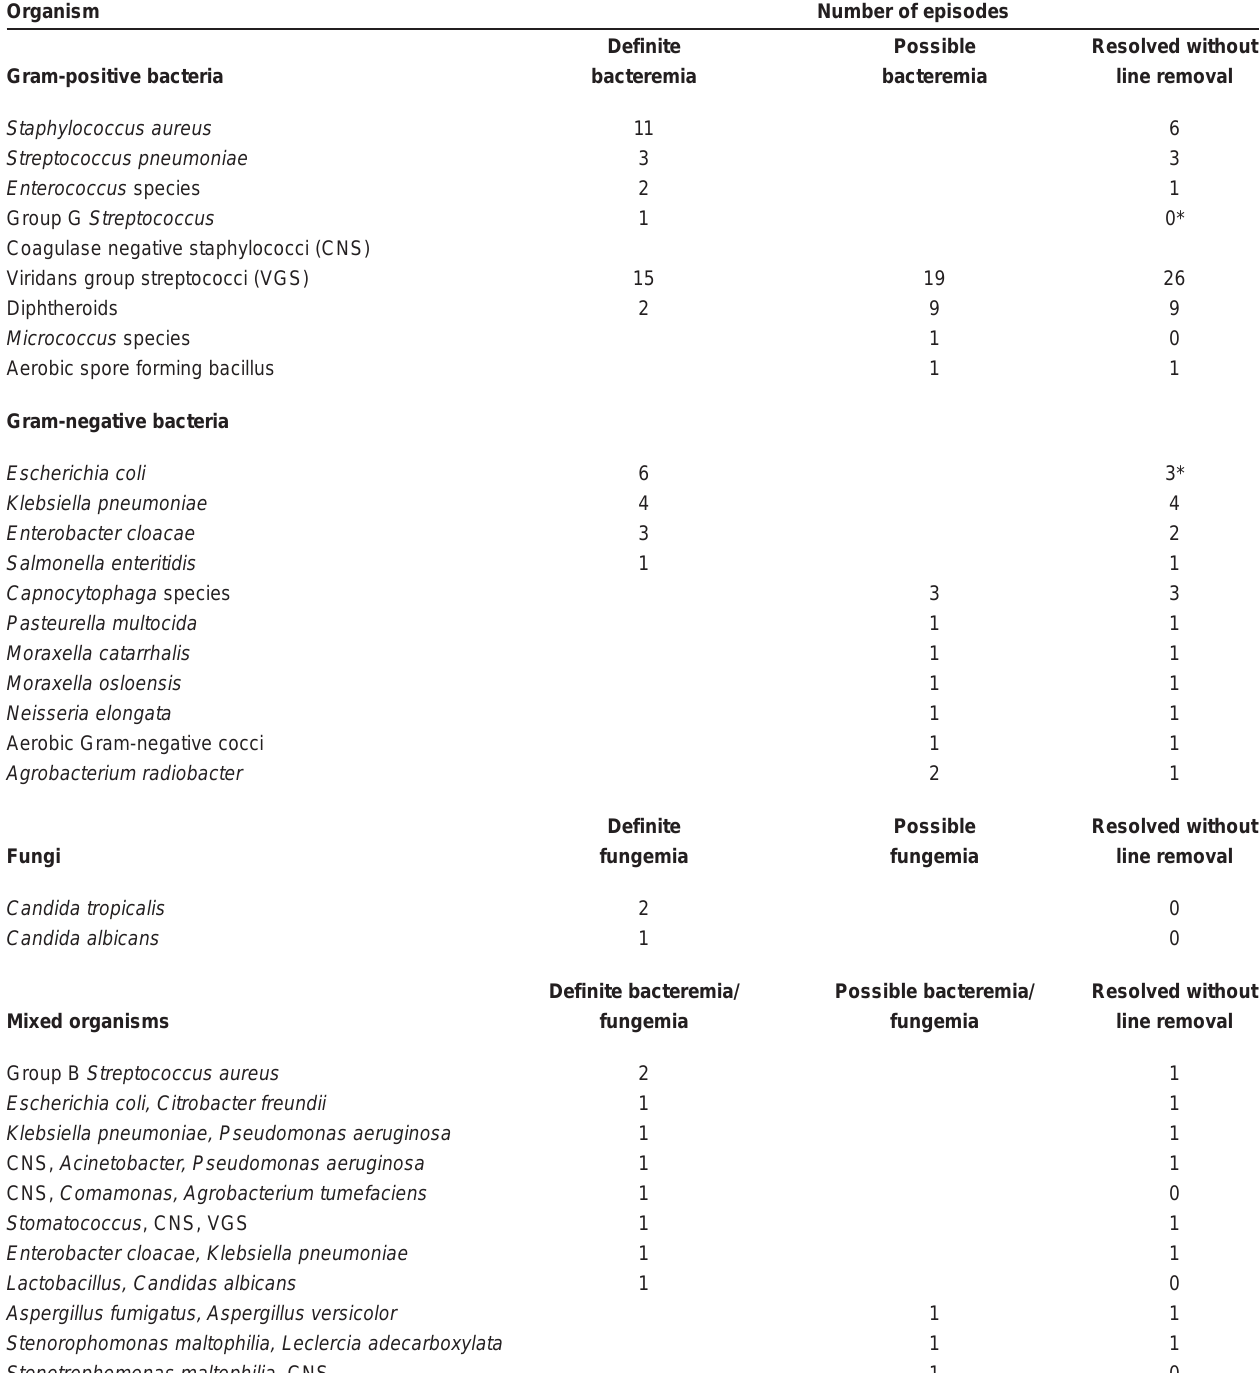
TABLE 1 The organisms grown from 104 episodes of bactermia and/or fungemia in paediatric oncology patients, 1994 to 1999